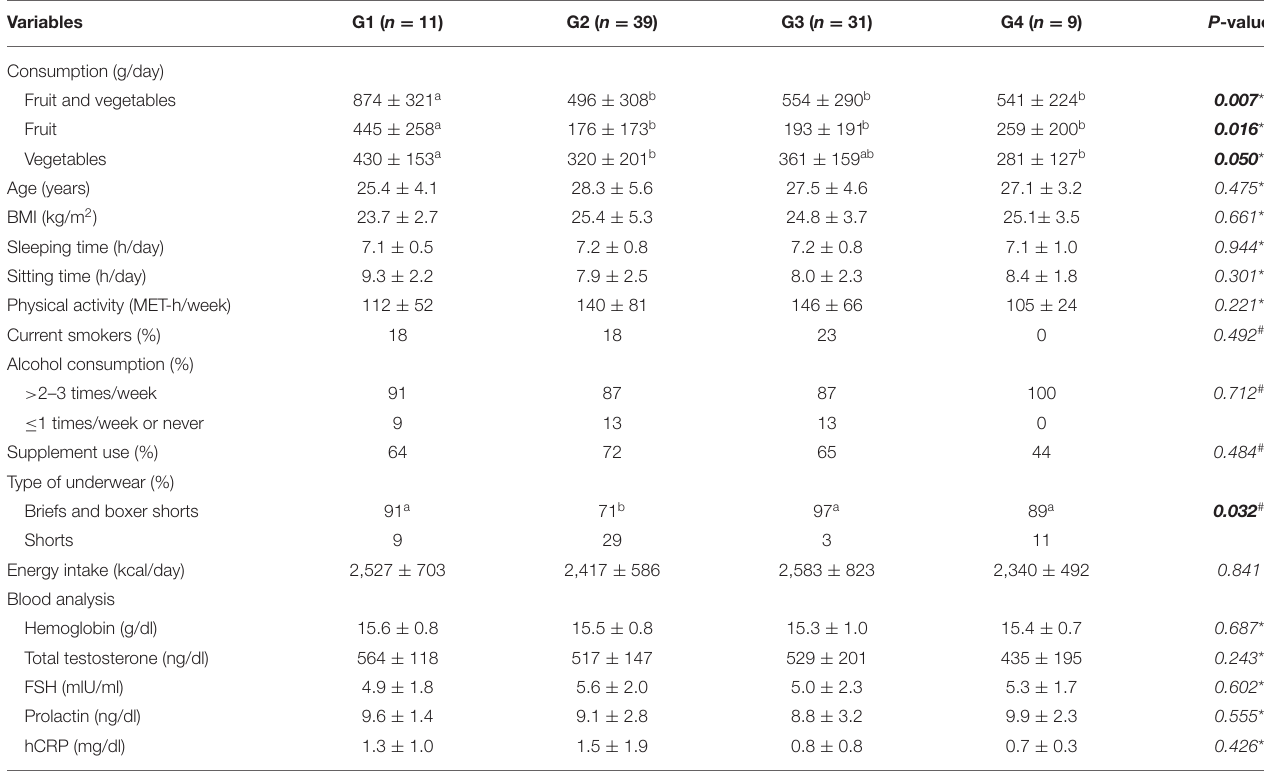
TABLE 1 | Baseline characteristics of participants (mean ± SD).